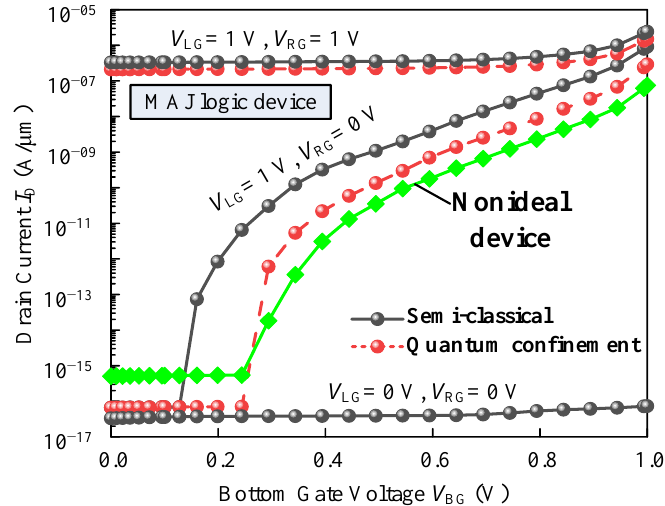
Figure 15. The transfer curves of the MAJ logic device extracted by TCAD simulation: (i) semi-classical, (ii) considering quantum confinement effect, and (iii) considering nonideal effects.